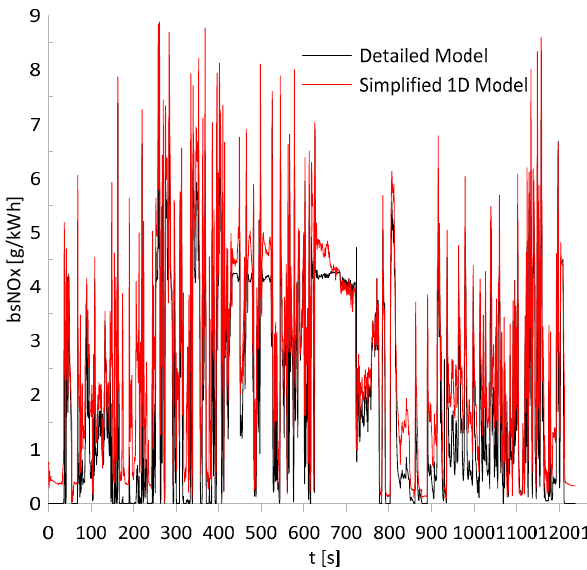
Figure 10. Brake specific NO x (bsNO x ) Comparison.